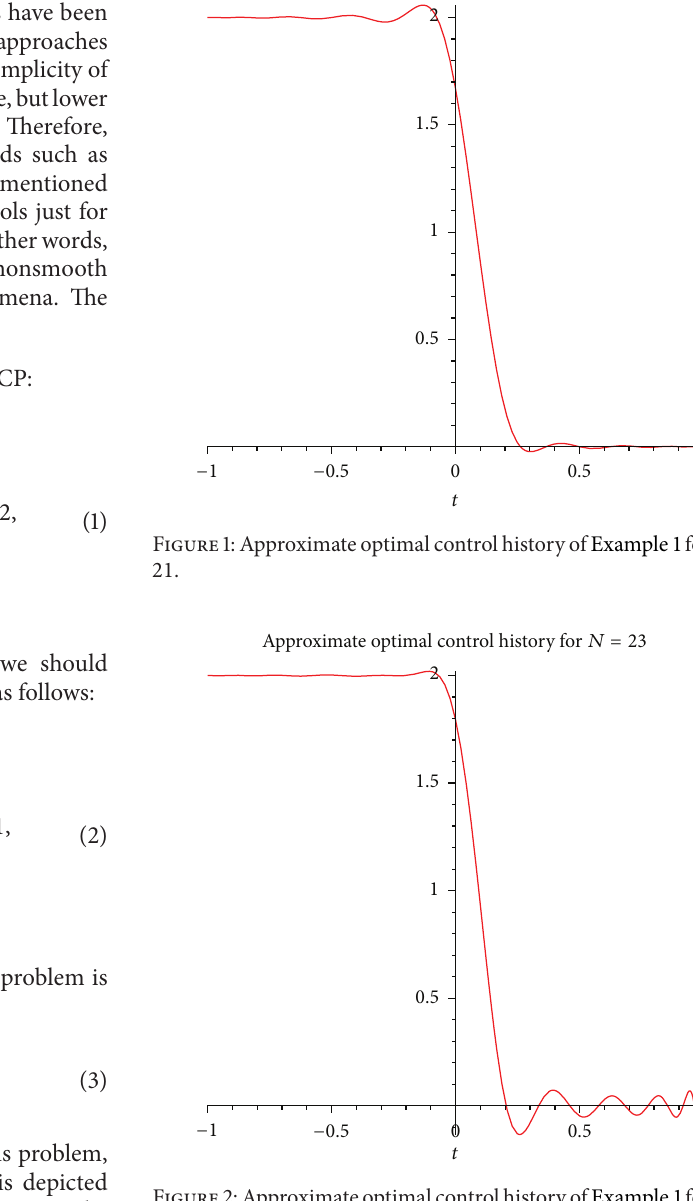
the integral form of the dynamical system is